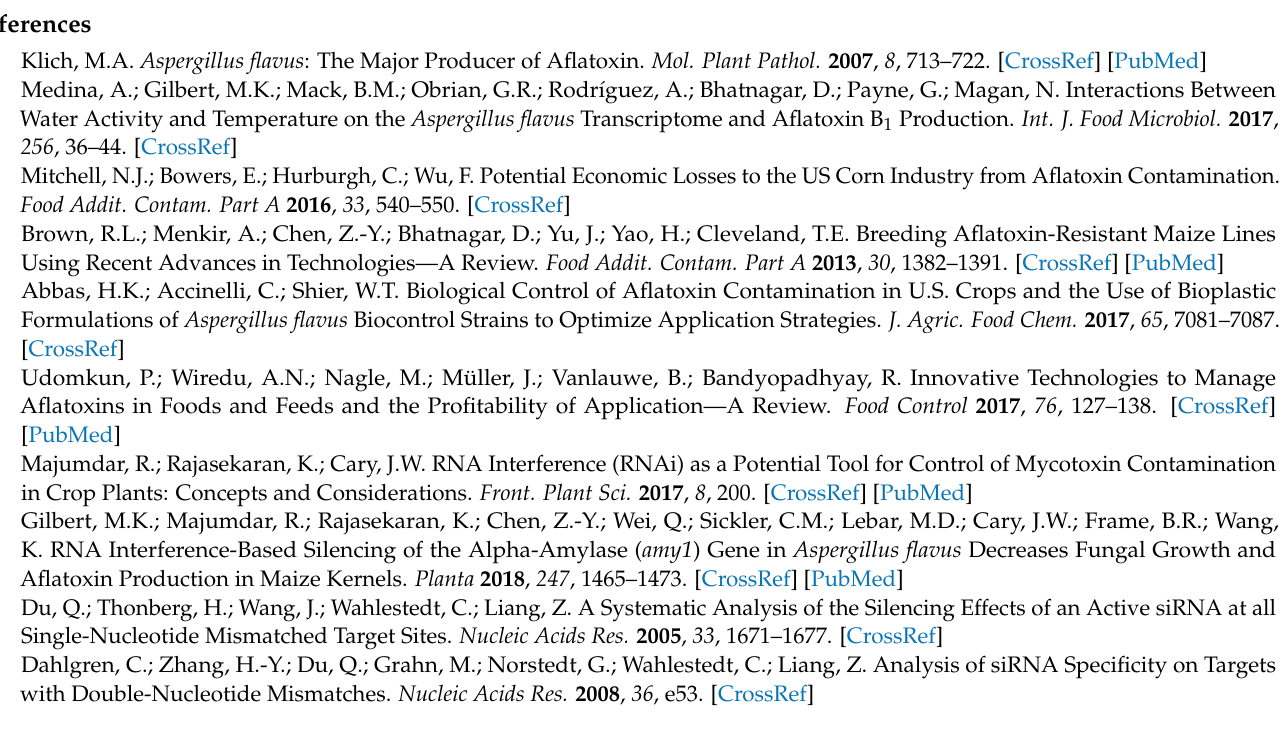
Figure S2: Details of knockout mutations; Table S1: Networking results for transcription